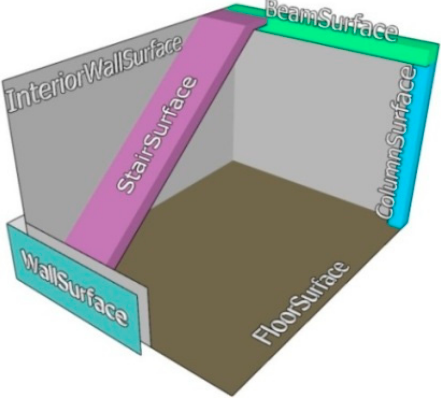
Figure 4. Interior representation of structures in ILoD1.